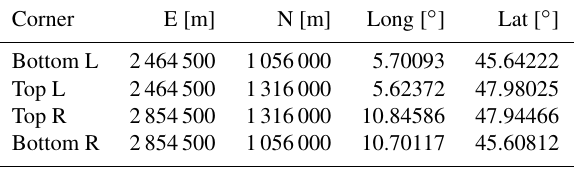
Table 1. Corner point coordinates for the study domain. E and N are the Swiss coordinates (CH1903+/LV95) in the east and north di- rections, respectively, while “long” and “lat” are the corresponding longitude and latitude. L and R stand for left and right, respectively.